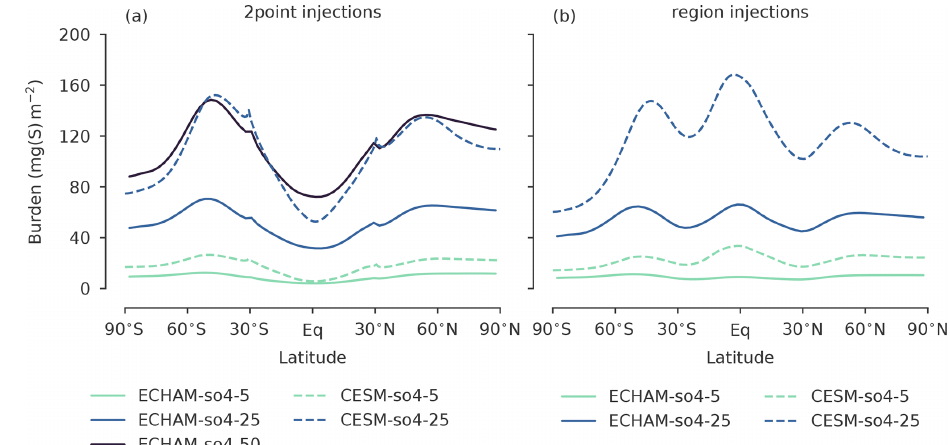
Figure 14. Zonal mean artificial sulfate burden for the 2point injections (a) and the region injections (b) of AM − SO 4 as a function of latitude. Solid lines indicate the ECHAM simulations; dashed lines indicate the CESM simulations. The artificial sulfate burden can be used as a very basic proxy for the amount of heating due to absorption of OTLR and